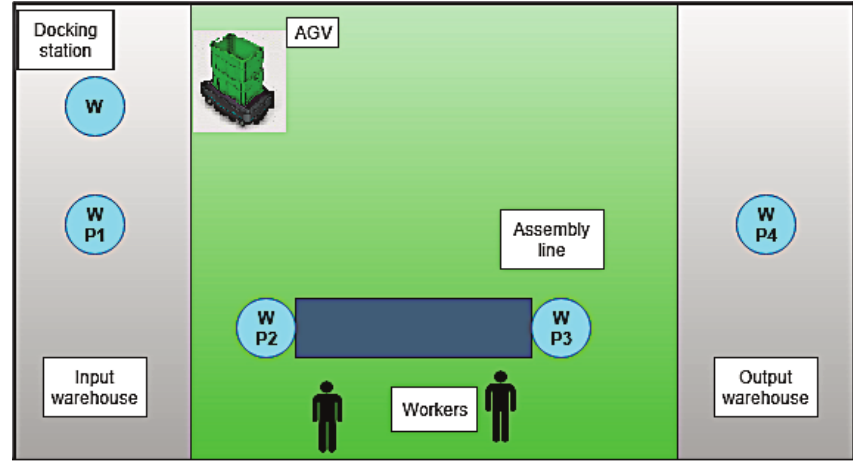
Fig. 3. Use case I – production floor